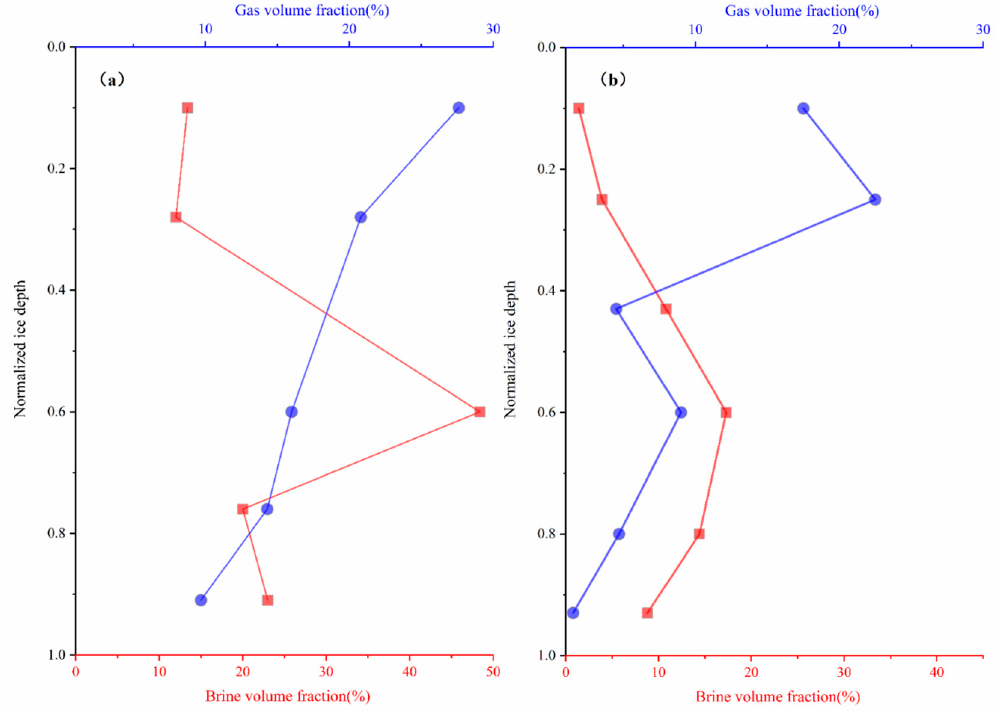
Figure 3. Sea ice brine volume fraction (red points) and gas volume fraction (blue points) versus normalized depth for ( a ) FYI and ( b ) MYI.